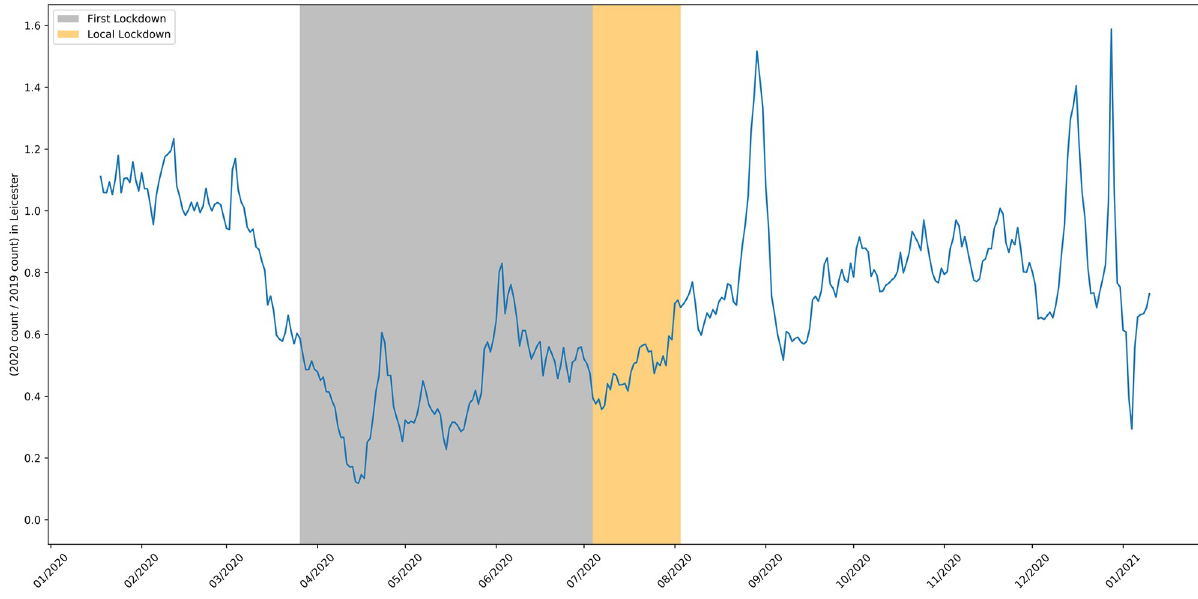
Fig 15. The 2020 to 2019 ratio of job adverts in the city of